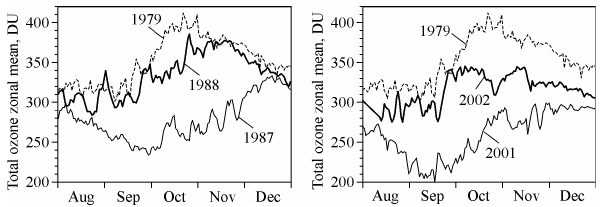
Fig. 1. (a) Variations in the daily zonal mean in the total ozone at 65 ◦ S during August–December 1988 (thick line) and 1987 (thin line) from the TOMS measurements. (b) The same for 2002 and 2001 (thick and thin lines, respectively). Dashed lines denote the pre-ozone hole year